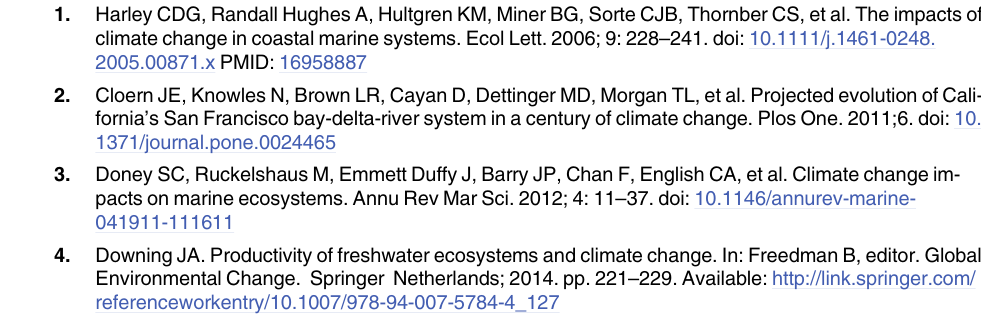
S2 Fig. Barplot of the relative food quality indices (FQI) calculated for both types of fatty acid data. The FQI is based on S LCEFA, as described in Eq 1. All raw fatty acid profiles (n = 666 for % FA and n = 101 for FA % DW), under all culture conditions, within these six algal groups (abbreviations follow Fig 1) were first averaged to 208 and 55 total unique species in each dataset, respectively (see Methods). The numbers of unique species averages in each index are plotted above each bar. S1 Table. Summary of all literature sources used in this synthesis. A total of 58 studies of the 399 screened had sufficient data on the culture conditions (light intensity, light duration, tem- perature, nutrients, growth phase, and salinity) and consistent FA variables for analysis beyond initial screening (see S1 File). S2 Table. Number of FA profiles in each of the algal groups in the full meta-analysis data set. Table is organized by FA data type and indicating the six major algal groups that are the focus of analyses. The FA observation (n profiles) in the ‘ included ’ category is the number of raw profiles that were used in the PCA (S1 Fig) or eligible for inclusion in the DISTLM analy- sis. S3 Table. Results of DISTLM marginal tests. Results of DISTLM marginal tests, quantifying the relative contribution of algal group affiliation and culture condition variables (following ab- breviations of Table 1) for both fatty acid datasets (% FA and FA % DW). The marginal tests result reports the proportion of the variation (prop. var.) explained by each variable, indepen- dent of any others (see